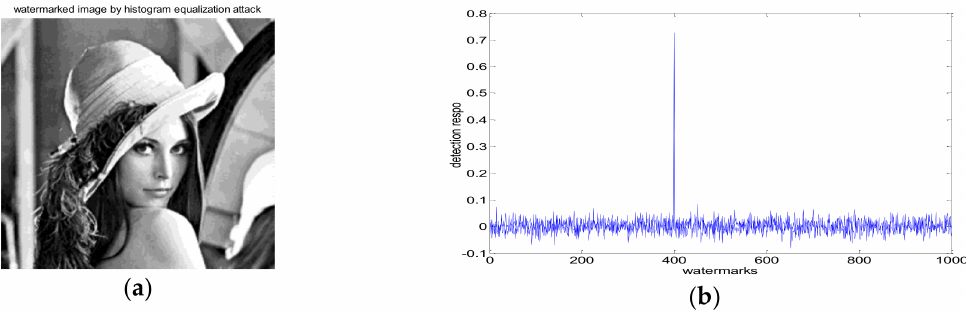
Figure 8. ( a ) Histogram equalization; ( b ) detector response.